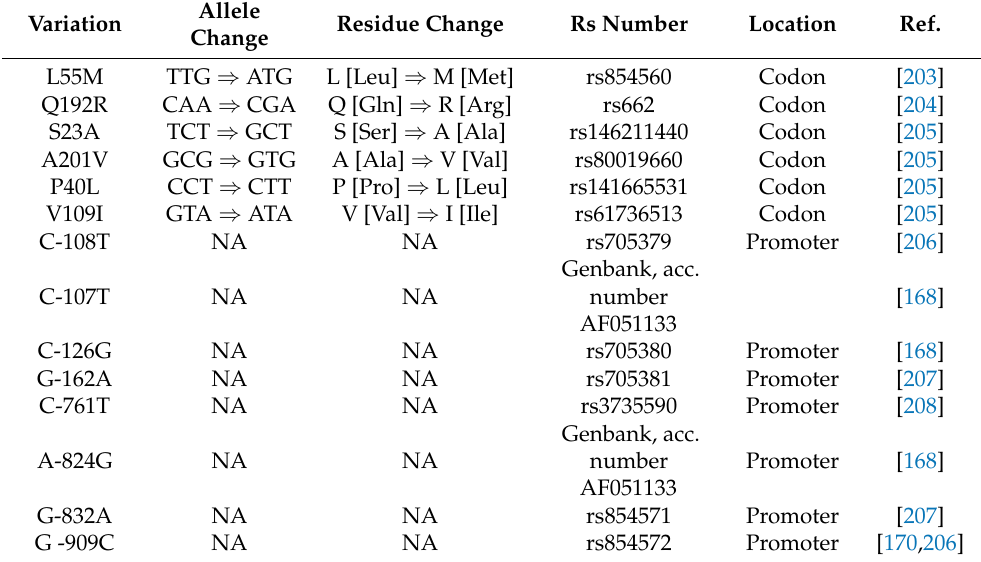
Table 1. Paraoxonase gene